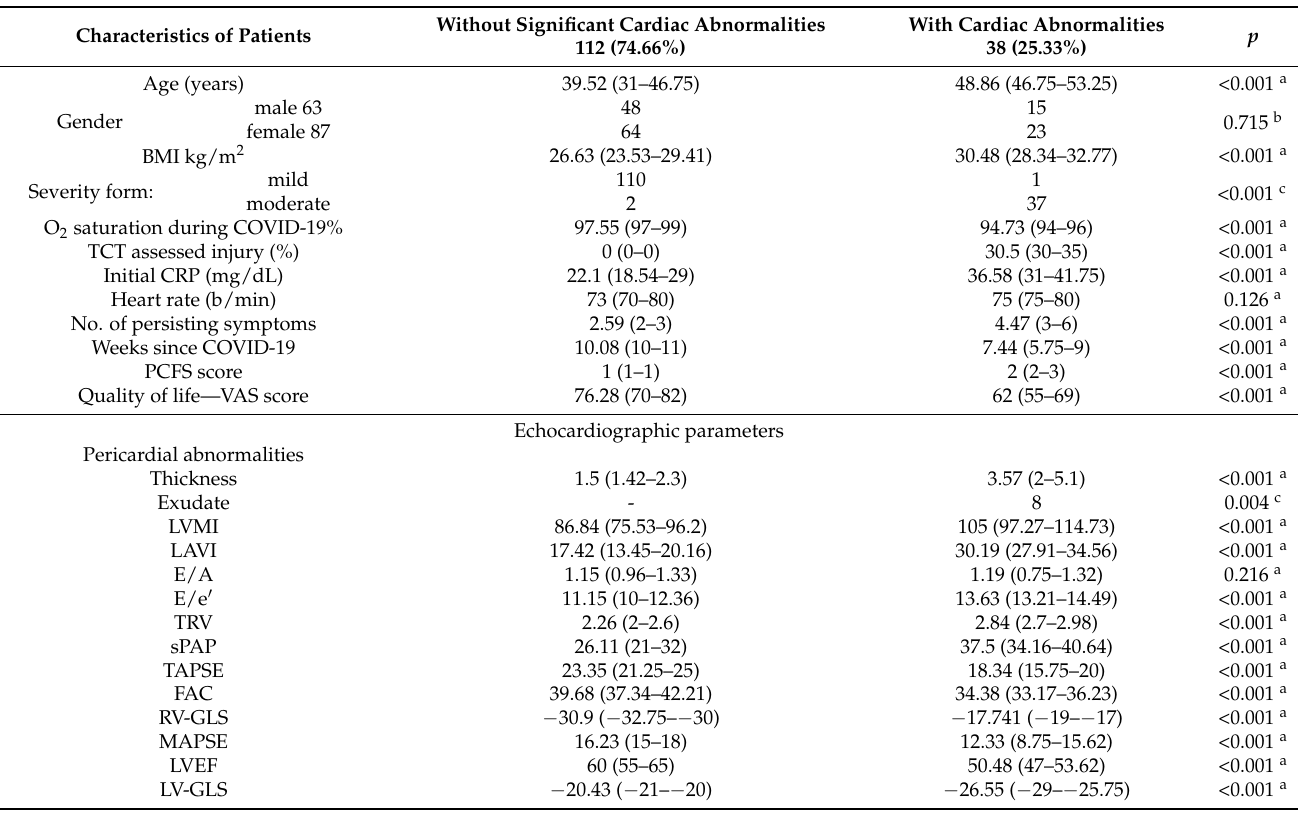
Table 1. Demographics, clinical and laboratory data in the patient group. Characteristics of